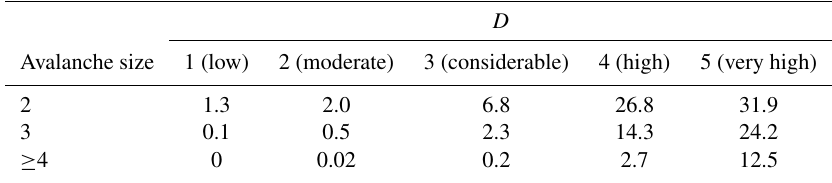
Table 2. Spatial density of natural avalanches ˜ ρ nat , i (or number of avalanches) of size i per 1000km 2 for each of the five danger levels D . Median values are shown.